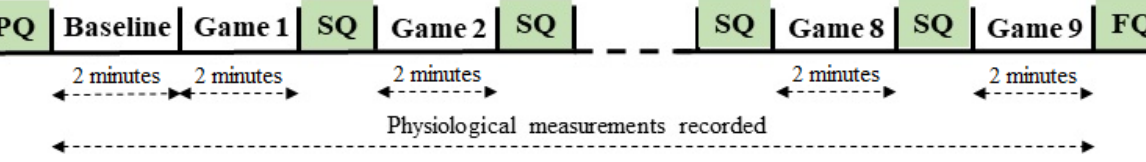
Figure 2. Summary of the study protocol. All participants first completed the personality questionnaires, rested for a 2-minute baseline period, then went through nine 2-minute gameplay intervals (game 1-9), with a short questionnaire after each. Physiological measurements were recorded throughout the baseline and gameplay and separated into 2-minute intervals for analysis. At the end, participants filled out the final outcome questionnaires. FQ: final questionnaire; PQ: personality questionnaire; SQ: short